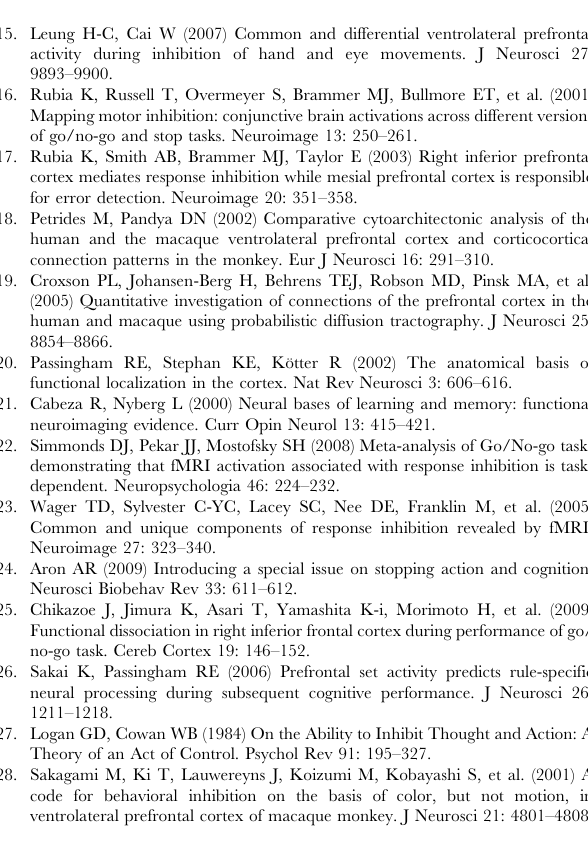
Table S1 List of clusters and coordinates from the group contrasts shown in Figure 2 of the main text. Table S2 List of clusters and coordinates from the PPI analysis. Table S3 List of PPI seed coordinates for individuals. Table S4 List of clusters and coordinates from the contrast of SST-NST response blocks (using block